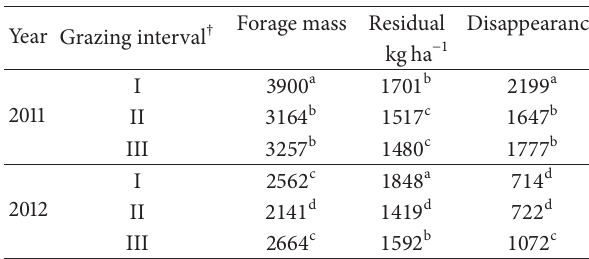
Table 2: Forage mass, residual forage mass, and forage disappear- ance of each grassland for two